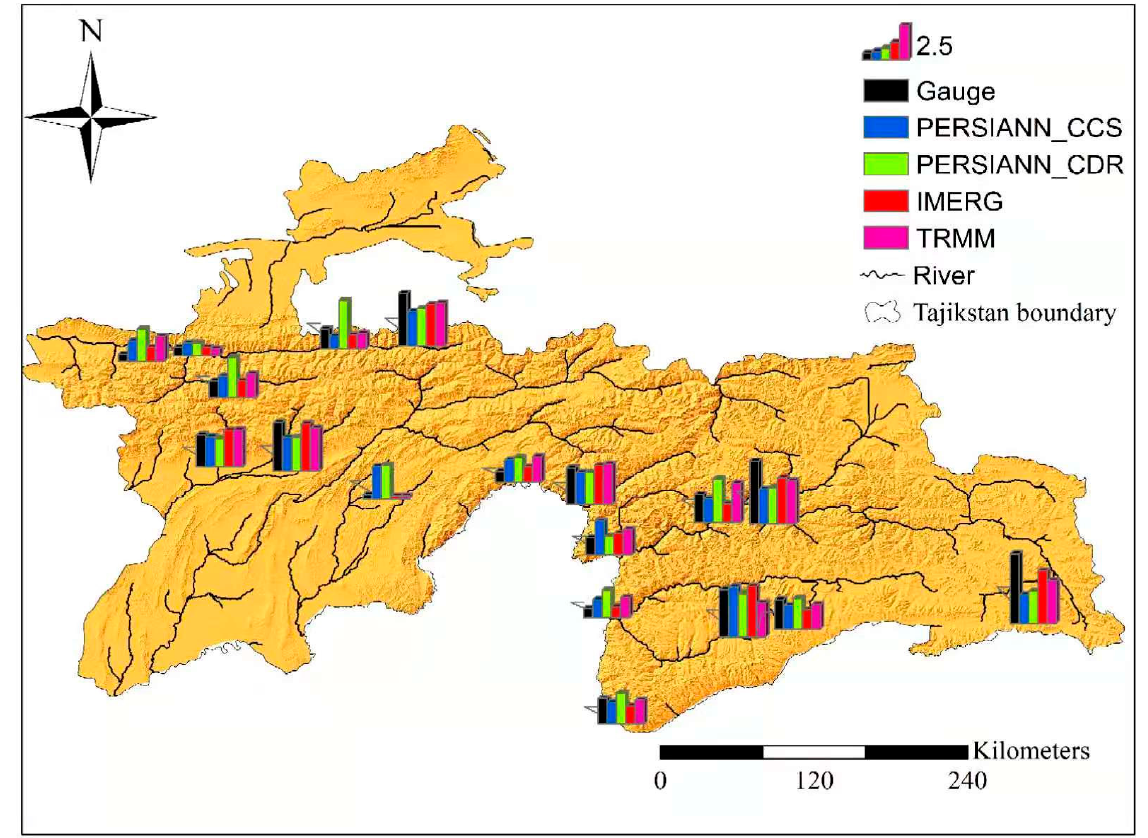
Figure 7. Comparison of daily spatial variability of all SBPD and gauge estimations.